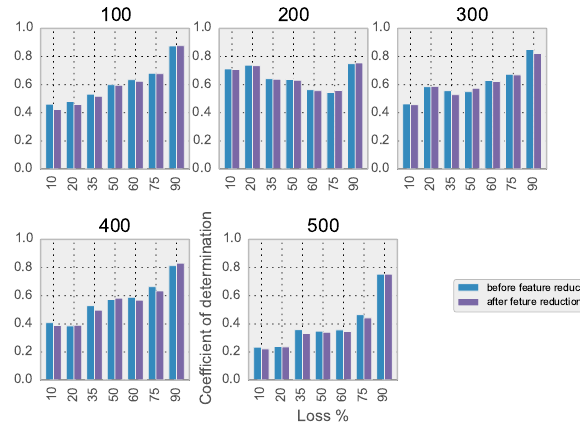
Figure 3: Coefficient of determination (COD) for regressors - different network sizes for 38 features model. Higher COD is better